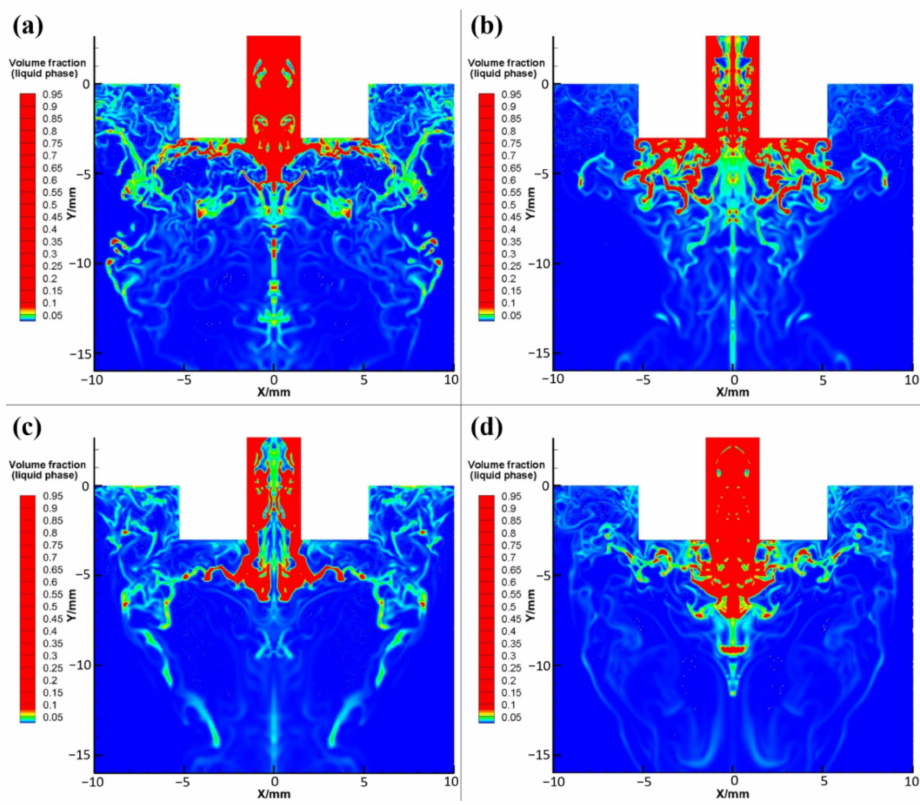
Figure 3. Flow pattern images of superalloy melt in the primary atomization process with different atomization pressures: ( a ) 2 Mpa, ( b ) 3 MPa, ( c ) 4 MPa, and ( d ) 5